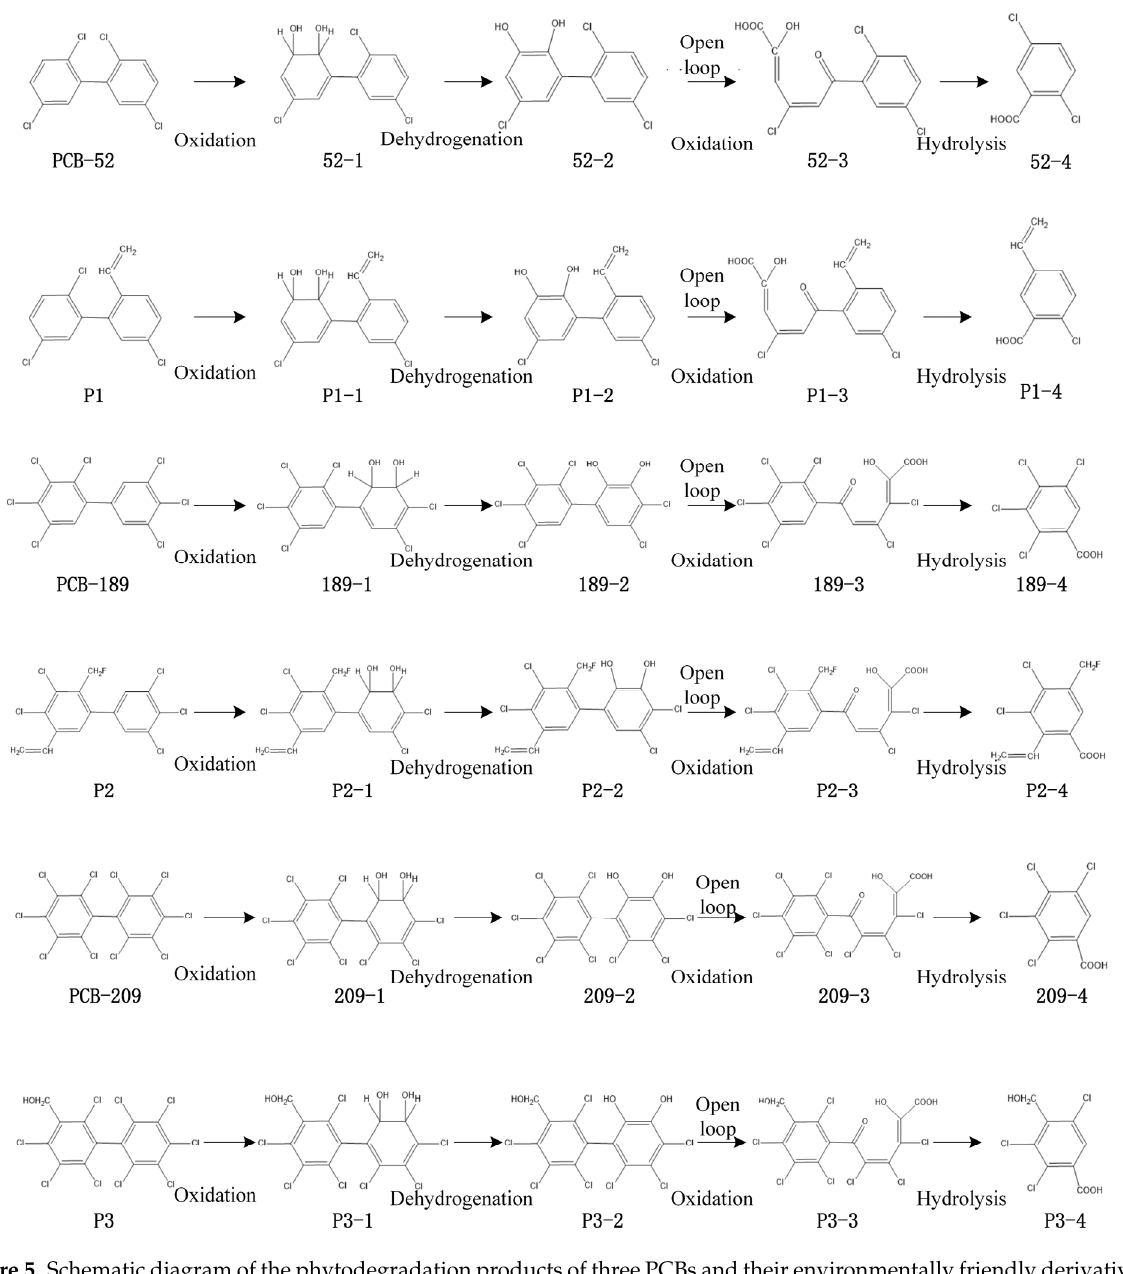
Figure 5. Schematic diagram of the phytodegradation products of three PCBs and their environmentally friendly